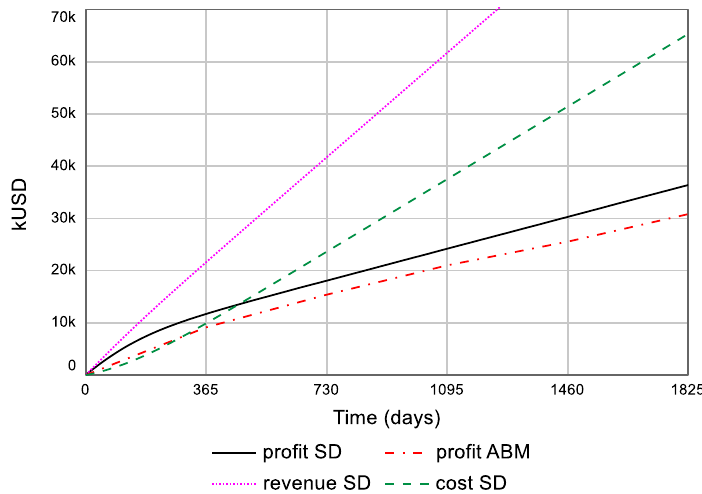
Figure 9. Cumulative revenue, cost, and profit over five years (1825 days). The cumulative profit calculated using the AB method is shown for comparison.